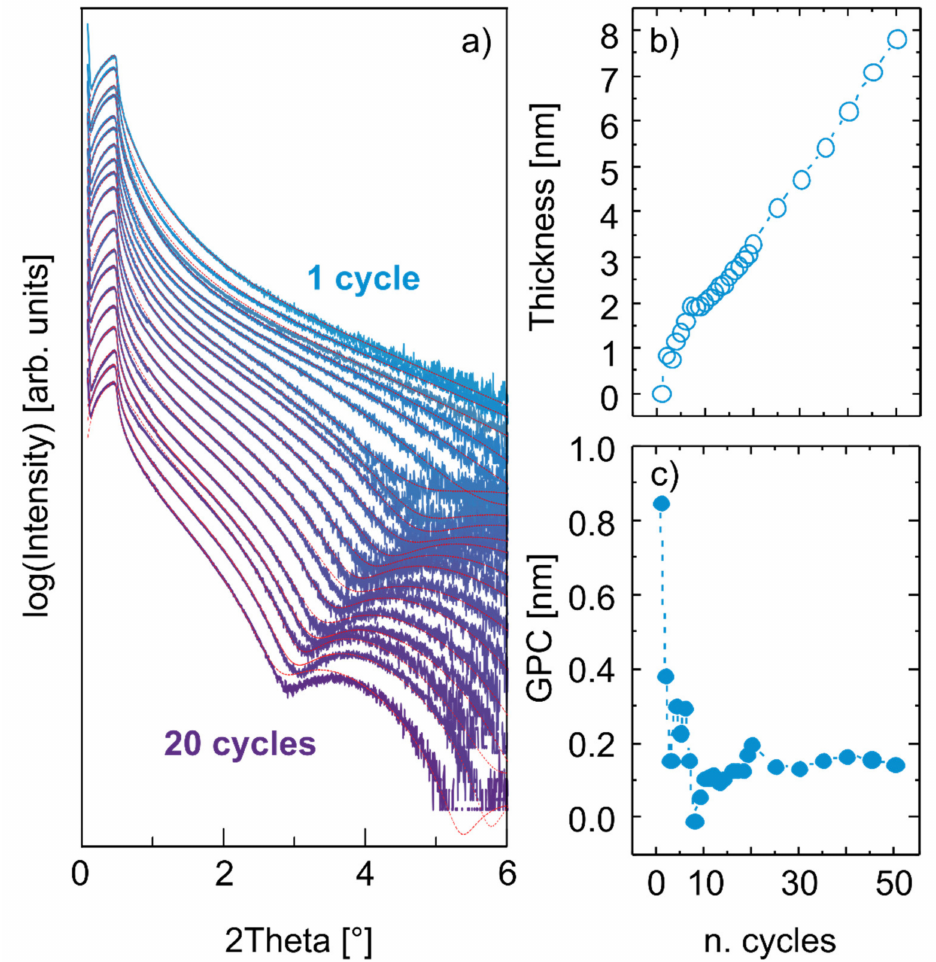
Figure 1. ( a ) XRR curves of the first (top) up to the 20th (bottom) PE-ALD ZnO cycle; the curves are stacked for clarity. The fitting curves are also reported with a red dashed line; ( b ) modelled ZnO layer thickness as determined from the XRR curves adopting a three-layer model vs. number of cycles; ( c ) growth per cycle (GPC) calculated from the XRR-derived thickness for all